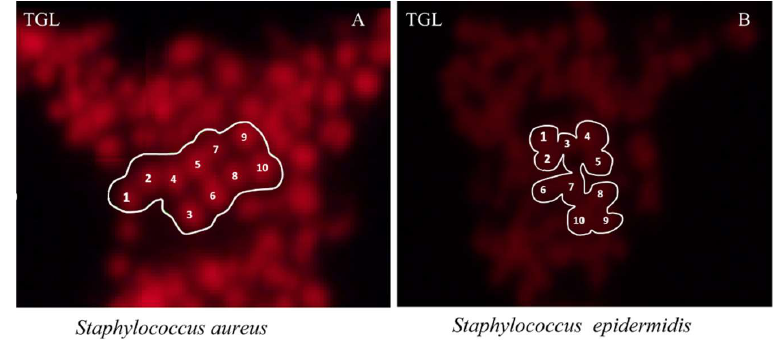
Figure 6. ( A ) The circles added indicate the 10 cells of ( A ) S. aureus and ( B ) S. epidermidis randomly selected for calculating an average SNR. ( A ) The mean signal of the 10 cells of S. aureus was calculated at S = 95.7, N = 3.1 and SNR = 31. ( B ) S. epidermidis was calculated at S = 32, N = 6.9 and SNR = 4.6.